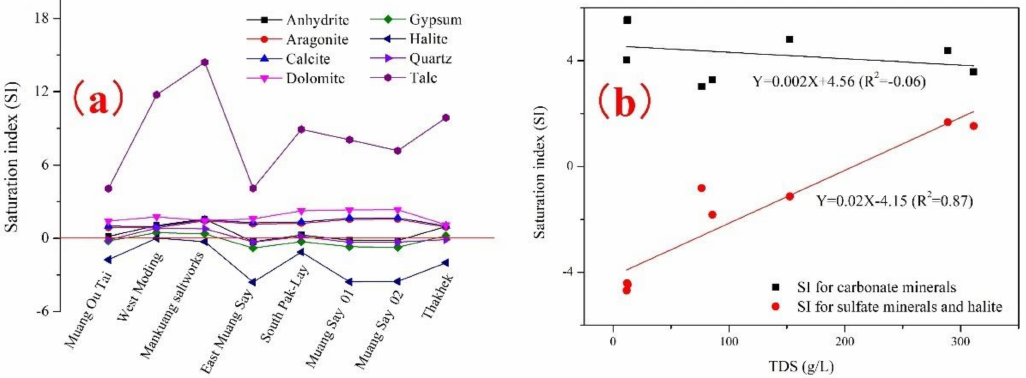
Figure 7. ( a ). Plot of the saturation indexes of saline spring water samples from north and central Laos. ( b ). Plot of TDS vs. saturation indexes (SI) of saline spring water samples from north and central